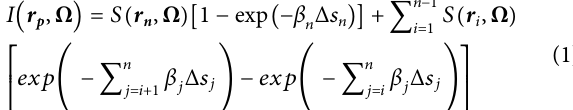
Frontiers in Energy Research |